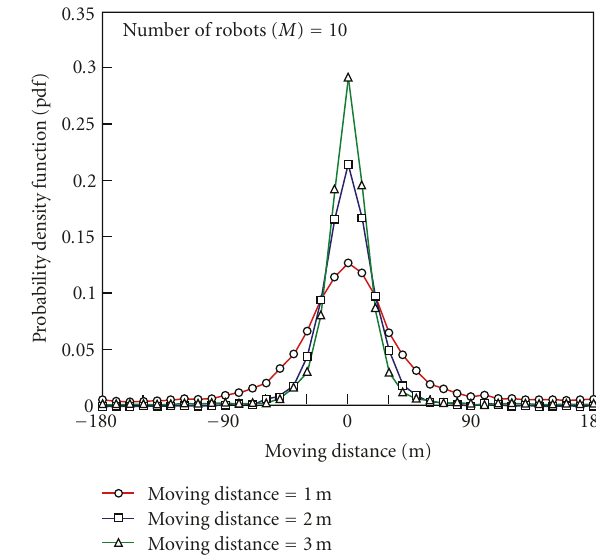
Figure 11: E ff ect of moving distance on heading direction estima- tion. Figure 12: Pdf of the angle estimation error.